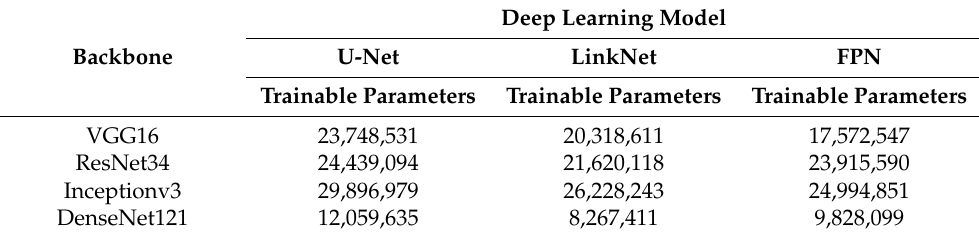
Table 3. Number of trainable parameters per model and backbone.